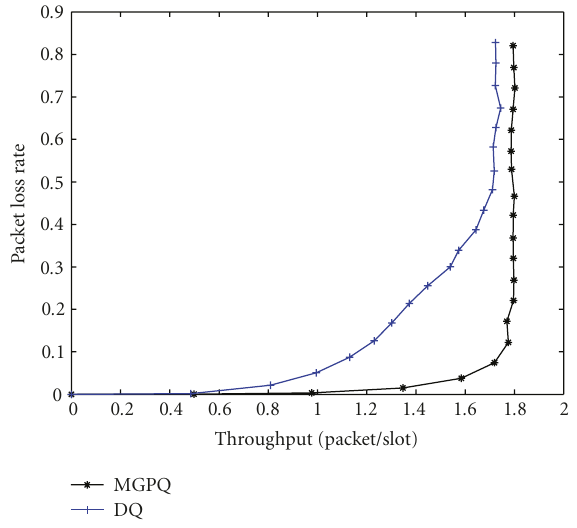
Figure 7: Packet loss ratio performance comparison between MGPQ and DQ.